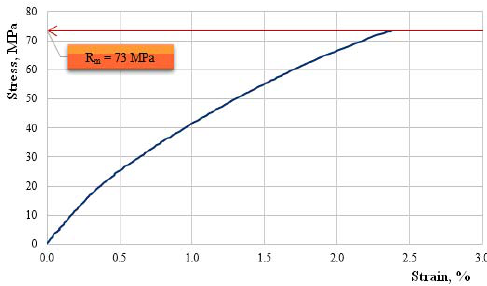
Figure 12. The characteristic curve for a representative sample of hemp fabric-reinforced composite material.